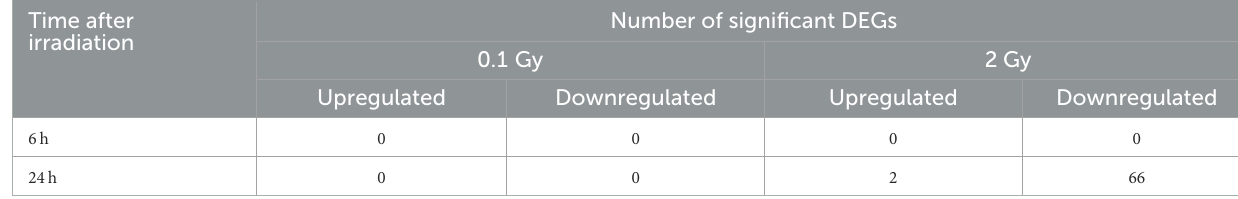
TABLE 5 Number of significantly differentially expressed genes (DEGs) in murine astrocytes after exposure to X-rays. Time after Number of significant DEGs irradiation 0.1 Gy 2 Gy Upregulated Downregulated Upregulated